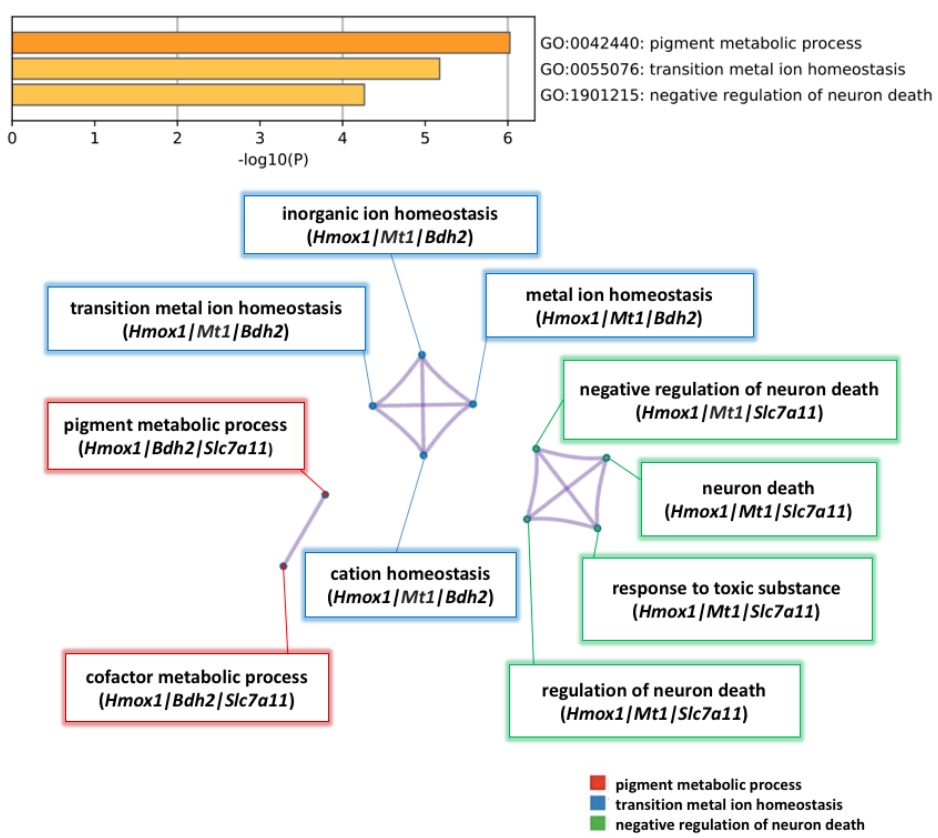
Figure 6. Pathway enrichment analysis of 5 significant genes up-regulated by NK-4. Heatmap of pathway enrichment analysis in the up-regulated genes. The three enriched terms in the category of biological process (BP) were pigment metabolic process, transition metal ion homeostasis, and negative regulation of neuron death. Nodes are clustered into subnetworks, and the included genes are shown under the respective pathways.